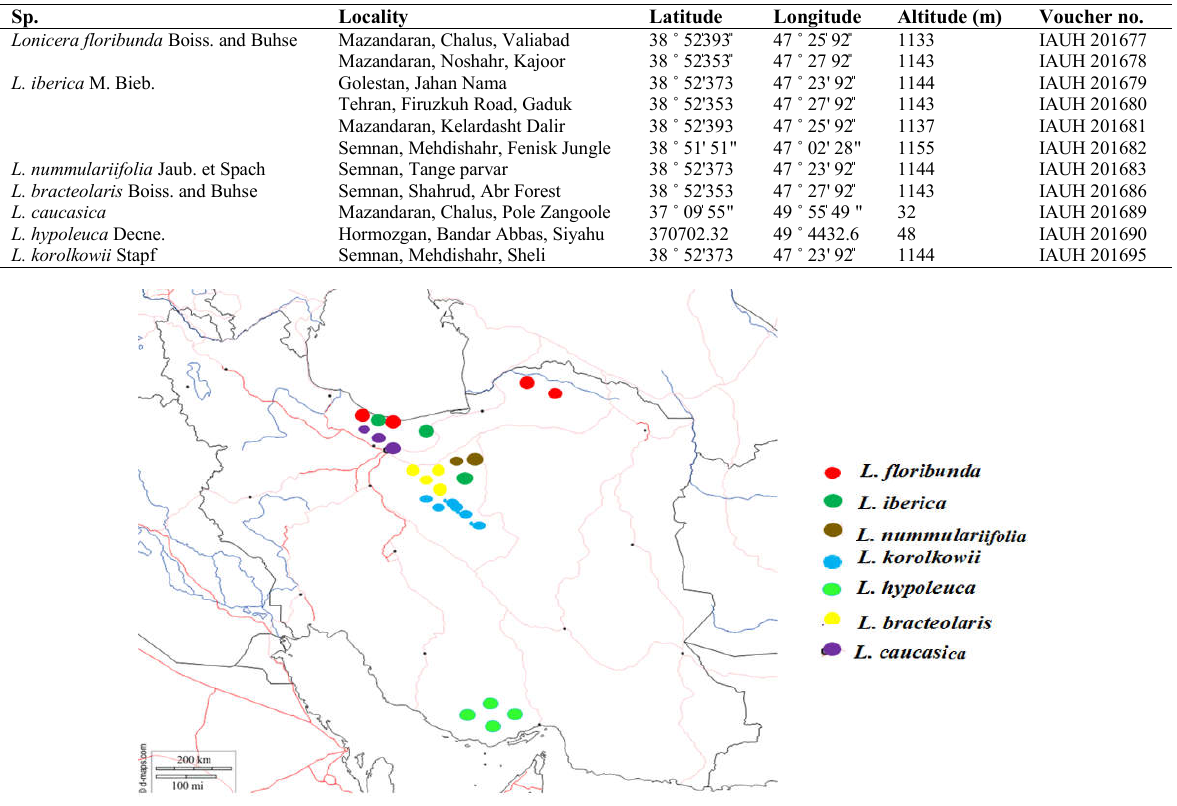
Fig. 1. Distribution map of studied